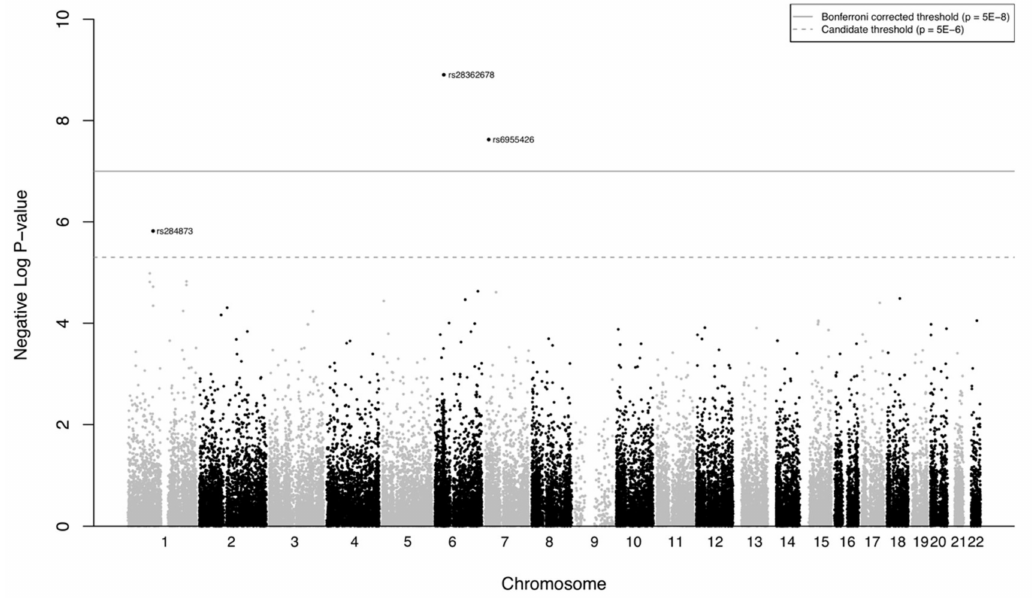
Figure 3. Manhattan plot for the genome-wide analysis of resettler